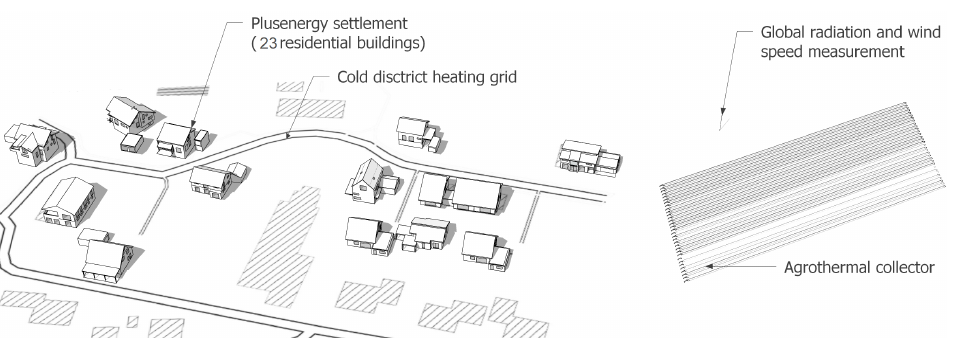
Figure 1. Plus energy settlement “Vordere